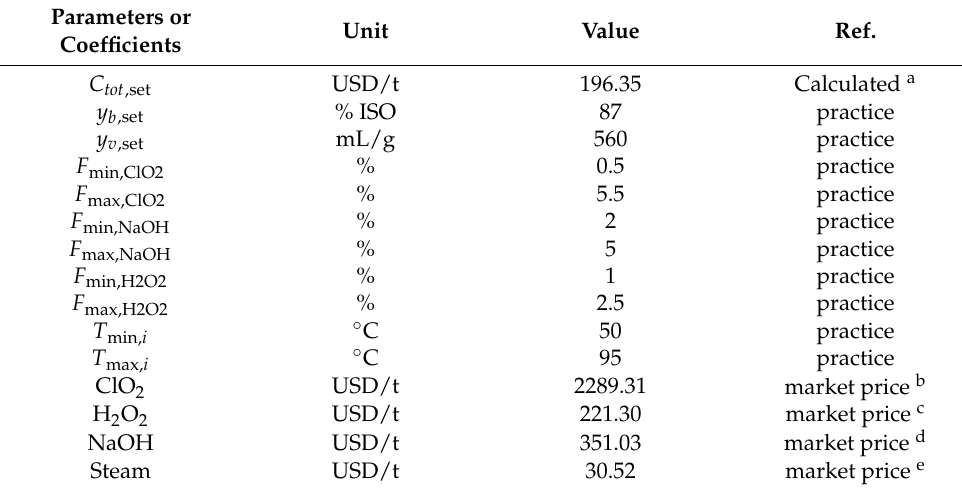
Table 2. Main model parameters and variables determined from